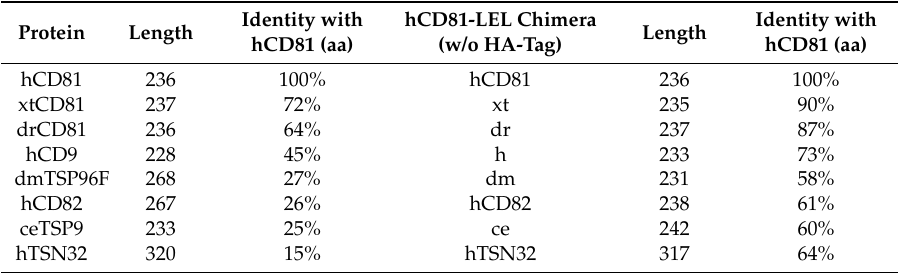
Table 1. Amino acid (aa) sequence identities of hCD81 paralogs, orthologs and chimeras used in this